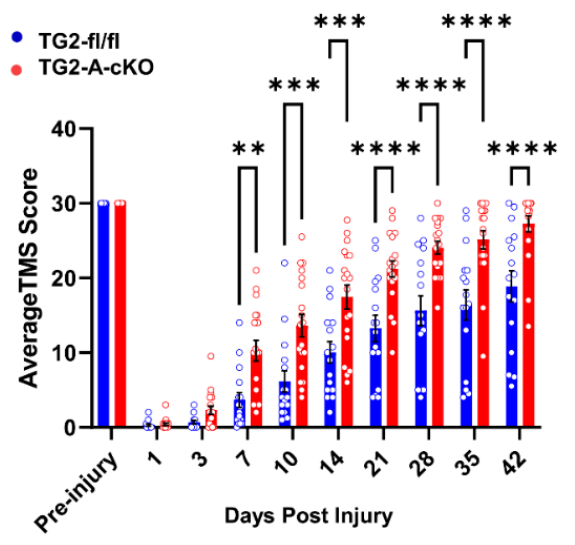
Figure 1. Deletion of TG2 from astrocytes improves functional recovery after spinal cord injury (SCI). TG2fl/fl and TG2-A-cKO mice at 12–16 weeks of age (12–15 mice in each group) were anesthetized and their spinal cords moderately contused bilaterally at T9. Motor function was assessed prior to injury and at the days indicated post-injury using the Toyama mouse score (TMS) [25]. Data are expressed as an average of the right hind limb and left hind limb. Data were analyzed by two-way ANOVA with a post hoc analysis using Bonferroni’s multiple comparisons test. ** p < 0.01, *** p < 0.001, **** p <